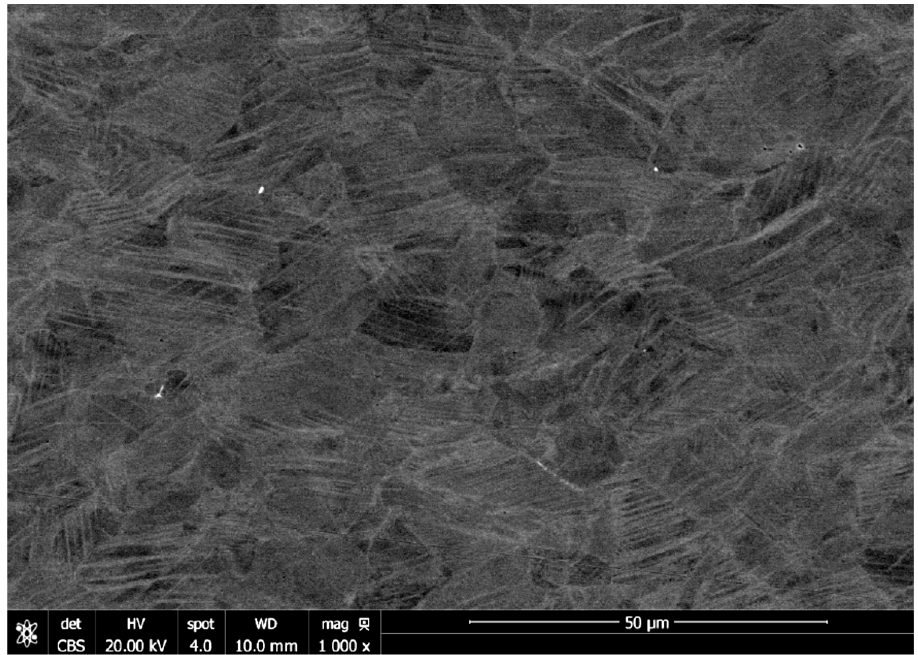
Figure 3. Microstructure of PHILOS plate at 1000 × .